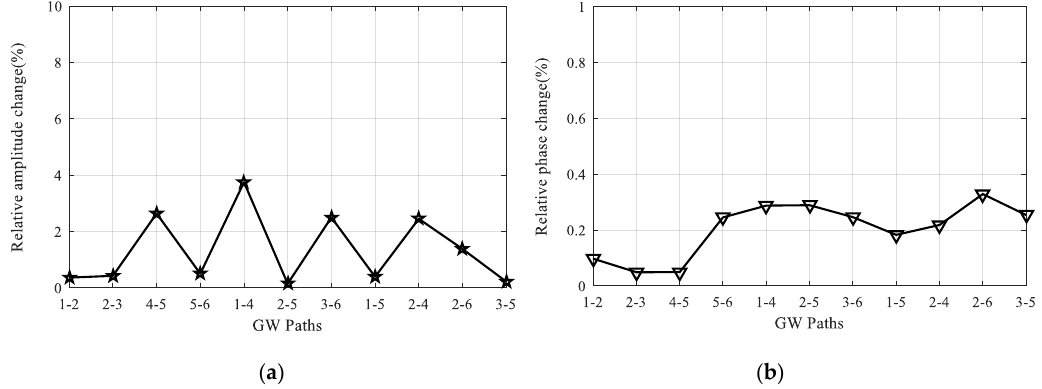
Figure 16. Relative signal change of all the paths after impact tests. ( a ) Relative amplitude change. ( b ) Relative phase change.